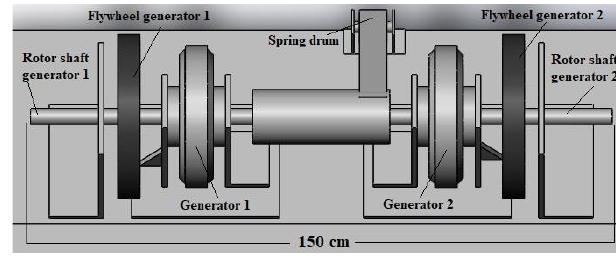
Fig. 3. Experimental generator